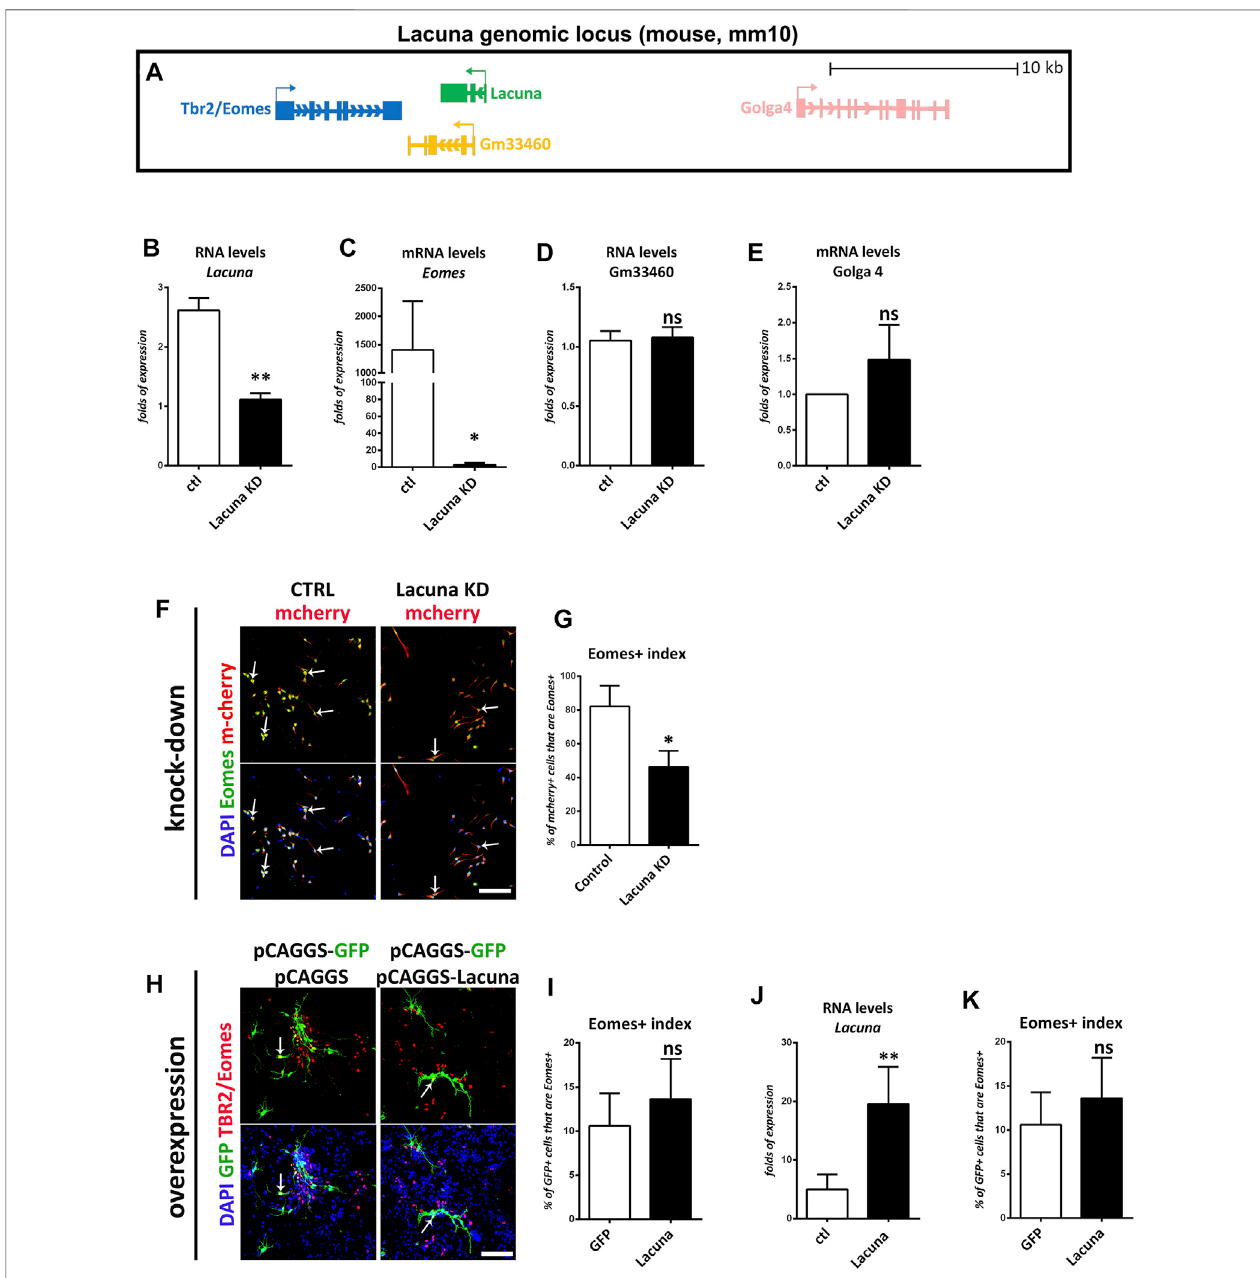
FIGURE 6 | Lacuna is necessary for Eomes expression in mouse Neural Stem Cells. (A) Scheme of Lacuna and Eomes locus on mouse chromosome 9. Despite their vicinity, Gm33460 and Golga4 are not affected by guide RNAs targeting Lacuna . (B) RNA levels of lncRNA Lacuna upon Lacuna knockdown (C) mRNA levels of Eomes upon Lacuna knockdown (D) RNA levels of Gm33460 upon Lacuna knockdown (E) mRNA levels of Golga4 upon Lacuna knockdown (F) Mouse Neural Stem cells were transfected with dCas9-KRAB-mcherry and sgRNA1 targeting Lacuna ( Lacuna KD-mcherry) or no guide RNA (CTRL-mcherry). They were immunostained for Eomes (green),mcherry (red) and labeled with DAPI. Scale bar: 100 μ m. (G) Quanti fi cation of Eomes positivecells in dCas9-KRAB-mcherry positive mouse Neural Stem cells (Control: 82.13 ± 7.091%, Lacuna KD: 46.27 ± 5.534%, p < 0.05, N (cid:2) 3 independent experiments, in total 239 cells for Control condition and 281 cells for Lacuna condition). (H) Lacuna and Control transfected mouse Neural Stem cells were immunostained for Eomes (red), GFP (green) and labeled withDAPI. Scale bar: 100 μ m. (I) Quanti fi cation of Eomes positive cells in transgene positive mouse Neural Stem cells (GFP: 10.60 ± 1.655%, Lacuna : 13.62 ± 2.046%, p > 0.05, N (cid:2) 5 independent experiments, in total 383 cells for Control condition and 309 cells for Lacuna condition). (J) RNA levels of lncRNA Lacuna upon Lacuna overexpression (K) mRNA levels of Eomes upon Lacuna overexpression. For all cases, * p < 0.05, ** p < 0.01, *** p < 0.001.